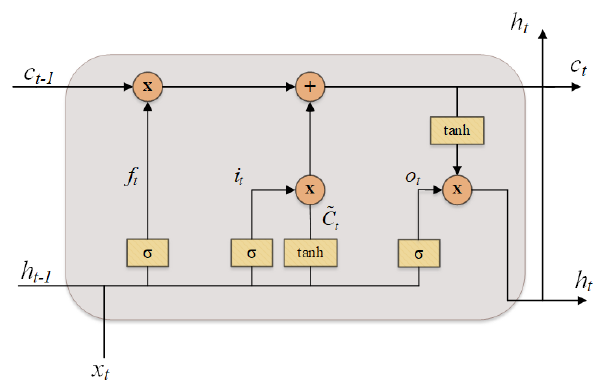
Figure 5. The structure of one cell conventional